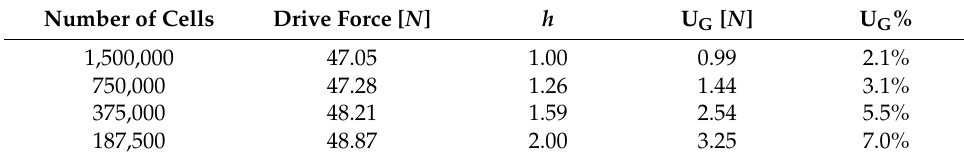
Figure 3. Drive force vs. relative grid size. Table 3. Estimated uncertainty for different grids.